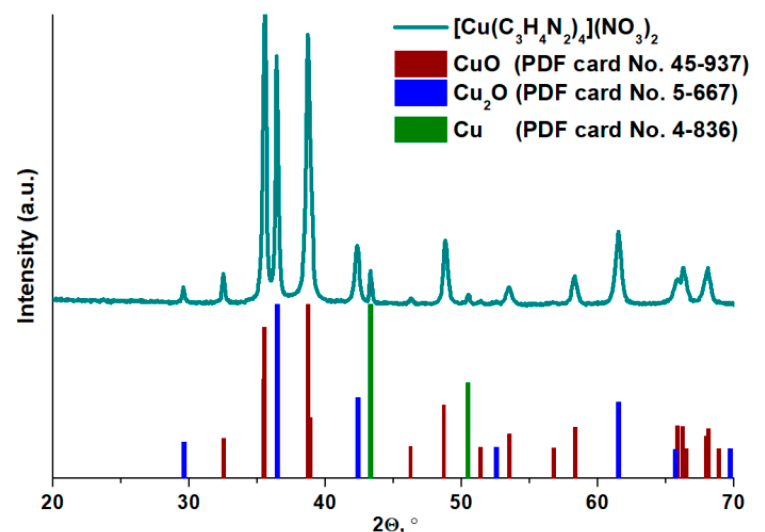
Figure 4. TEM data for solid products obtained by combustion of [Cu(C 3 H 4 N 2 ) 4 ](NO 3 ) 2 complex under air: ( a , b ) morphology and ( c , d ) fast Fourier transform (FFT) patterns are calculated from the TEM image of individual particles.